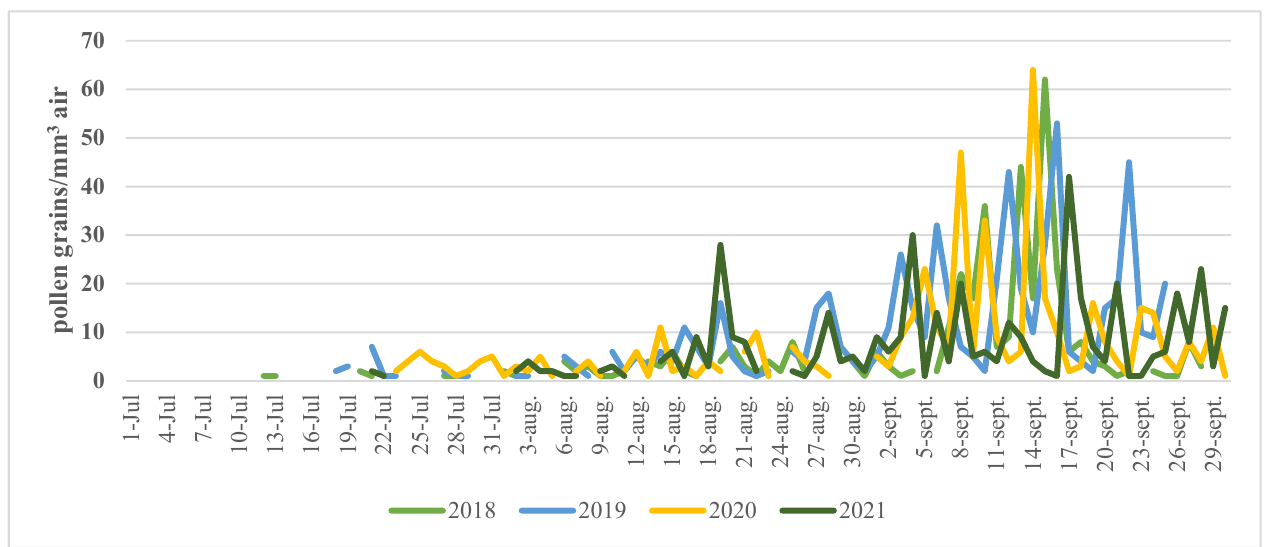
Figure 4. Daily Ambrosia pollen concentration during the season between 2018–2021. Our air pollen recordings from Bucharest proved that Ambrosia is a significant compo- nent of the biological pollution in the largest Romanian city from the South region, which is regions and in rural areas [31]. Note that the year 2014 was the hottest year on